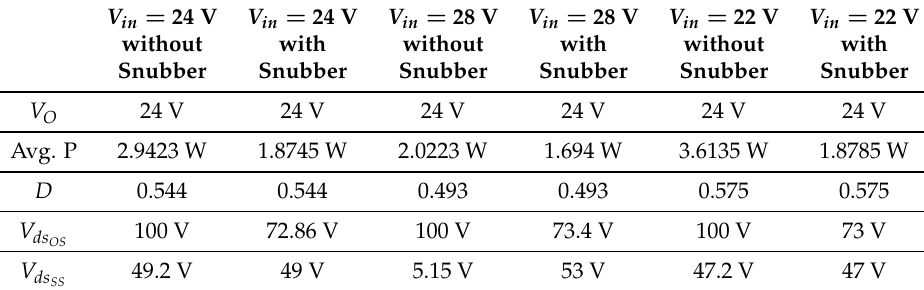
Table 2. Simulation results